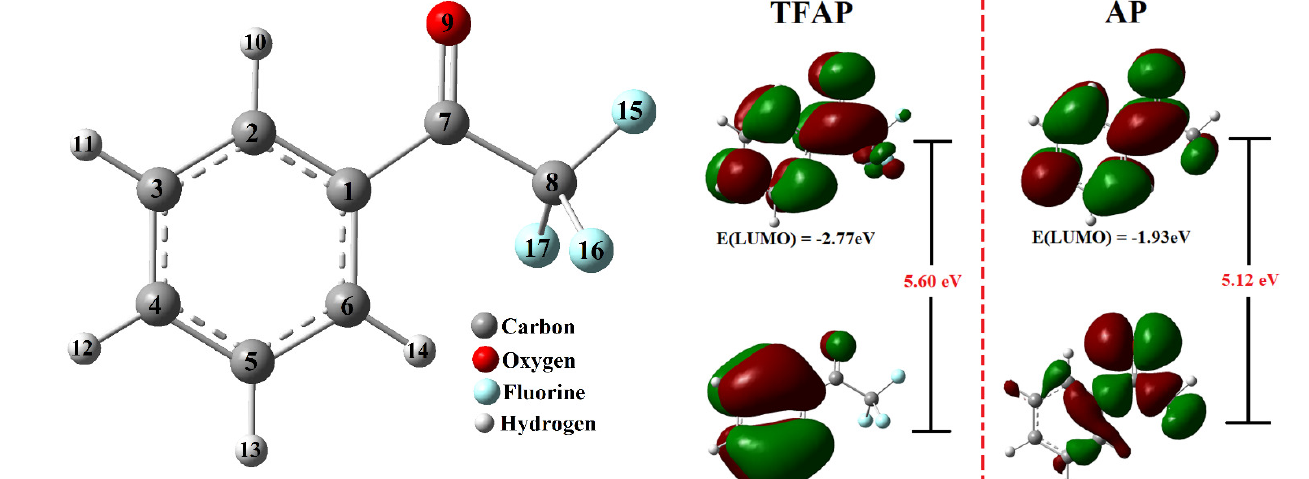
2.480 and 2.550Å are calculated to be 2.4782 and 2.4784Å respectively. This could be the reason for the slight elonga- tion of C −F and C −F bond lengths (1.354Å) compared 8 15 8 17 to the C −F bond length 8 16